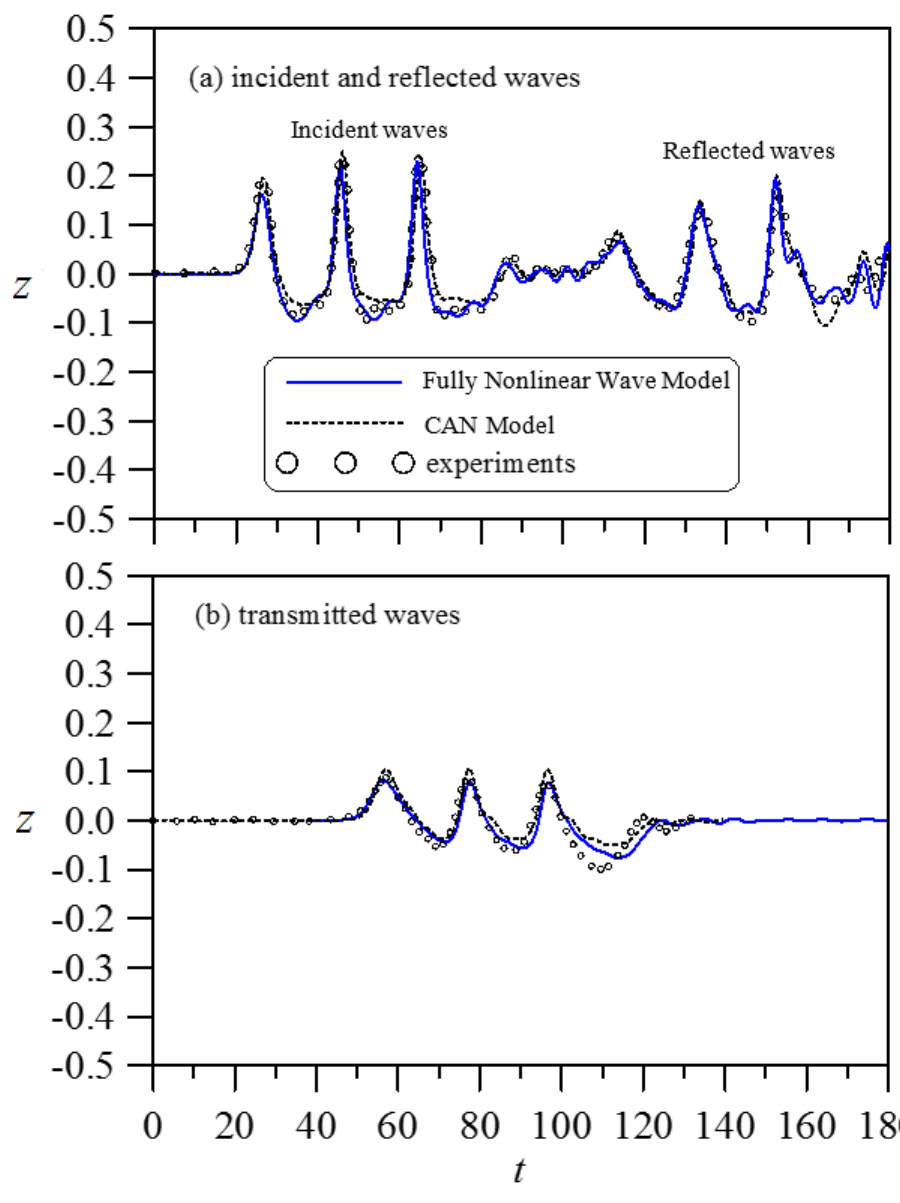
Figure 6. Comparisons of the incident and reflected wave profiles in subplot ( a ) and transmitted wave profiles in subplot ( b ) obtained from the present CAN model, a FNWM, and measured data for a cnoidal wave encountering a partially submerged body with h 1 = 0.5, L = 4. The incident cnoidal wave conditions are α = 0.3 and λ = 20.